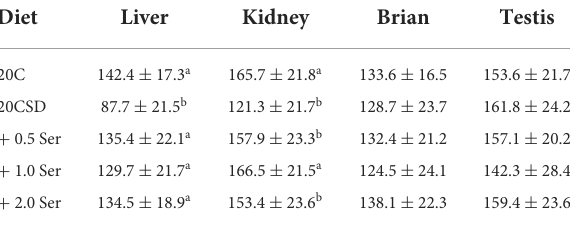
TABLE 3 Effects of supplementation of serine-deprived diet with serine (0.5, 1.0, and 2.0 times the amount of serine in 20C) on GPx1 gray scale at organs in rats fed a 20% casein diet (experiment 1).